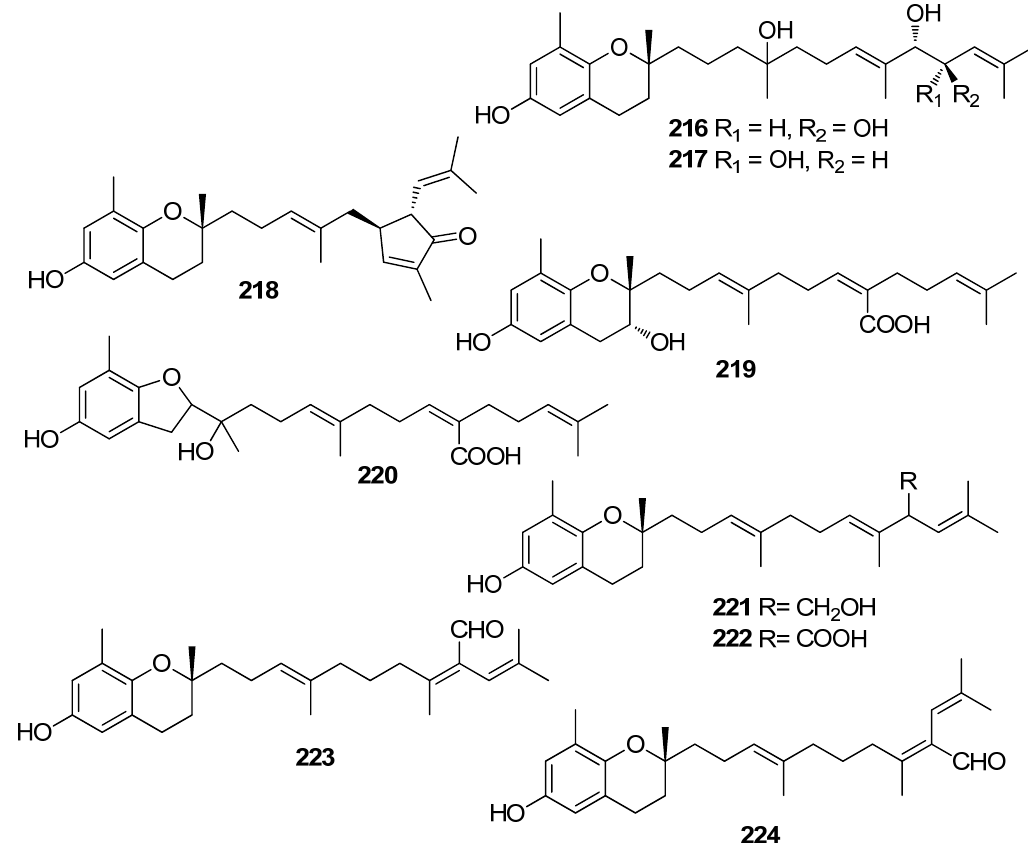
Figure 19. Chemical structures of compounds 216 – 224 . Jung et al. (2008) isolated an array of meroterpenoids ( 174 , 175 , 178 – 194 ) from